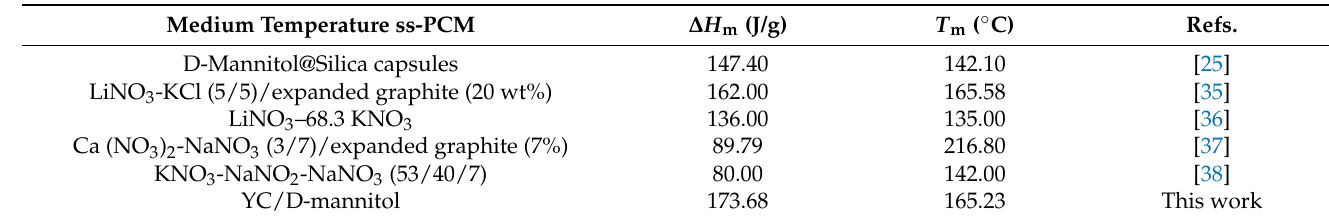
Table 3. Current advances of the medium temperature ss-PCMs. The thermal performance values of the ss-PCMs are compared.